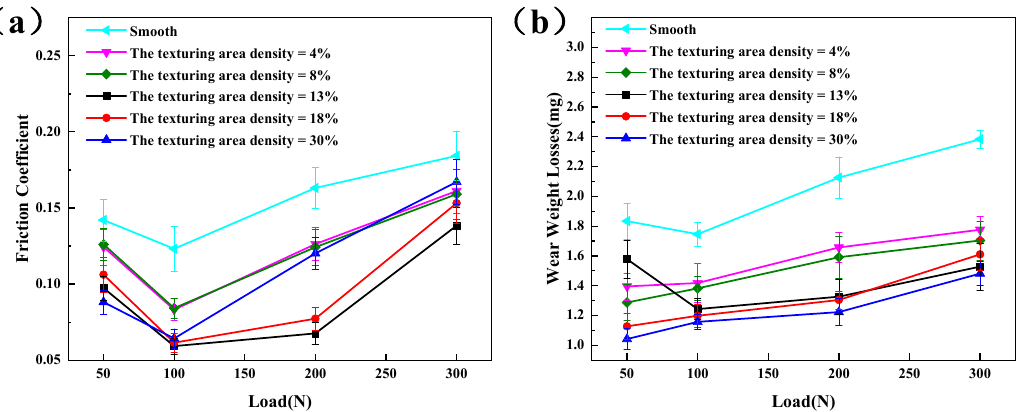
Figure 8. E ff ect of di ff erent texture densities on the friction coe ffi cient and the wear-weight loss at a Figure 8. Effect of different texture densities on the friction coefficient and the wear-weight loss at a constant speed of 100 rpm: ( a ) friction coe ffi cient, and ( b ) wear-weight constant speed of 100 rpm: ( a ) friction coefficient, and ( b ) wear-weight losses.